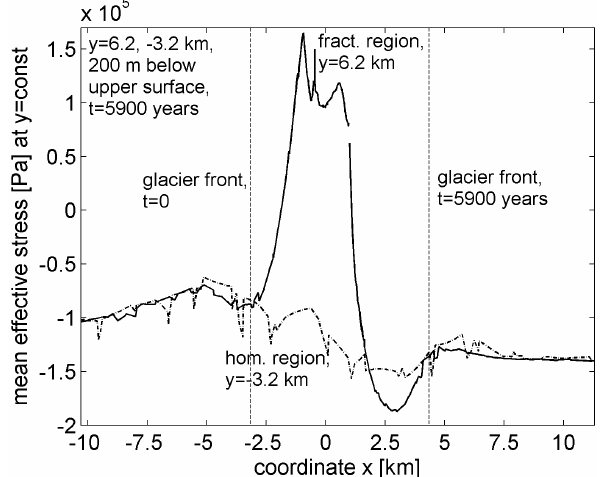
Figure 17. Temperature change [ ◦ C] in the rock mass at the upper surface and at a depth of 800m and at time 5900 years.